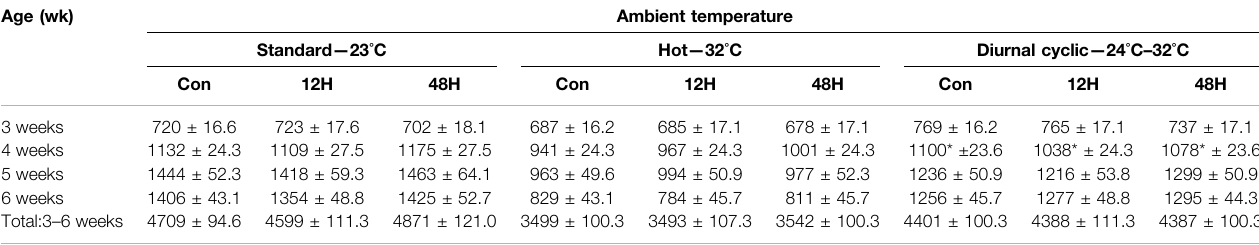
TABLE 4 | Feed intake (kg per week) of broilers exposed to different hypoxiaregimes during embryonic development and then raised under different environmental ambient temperatures (analyzed within each ambient temperature).